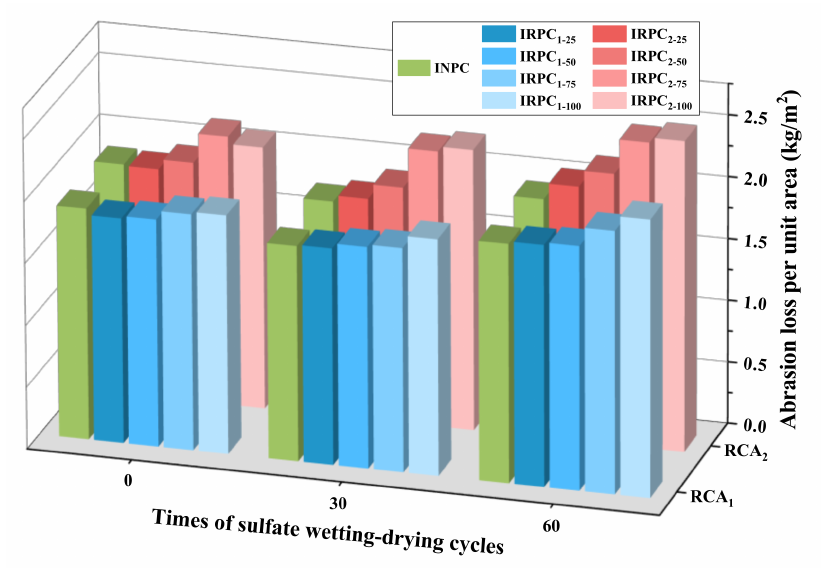
Figure 7. Abrasion loss per unit area on the surface layer of IRPC with variable replacement rates after different sulfate wetting-drying cycles.